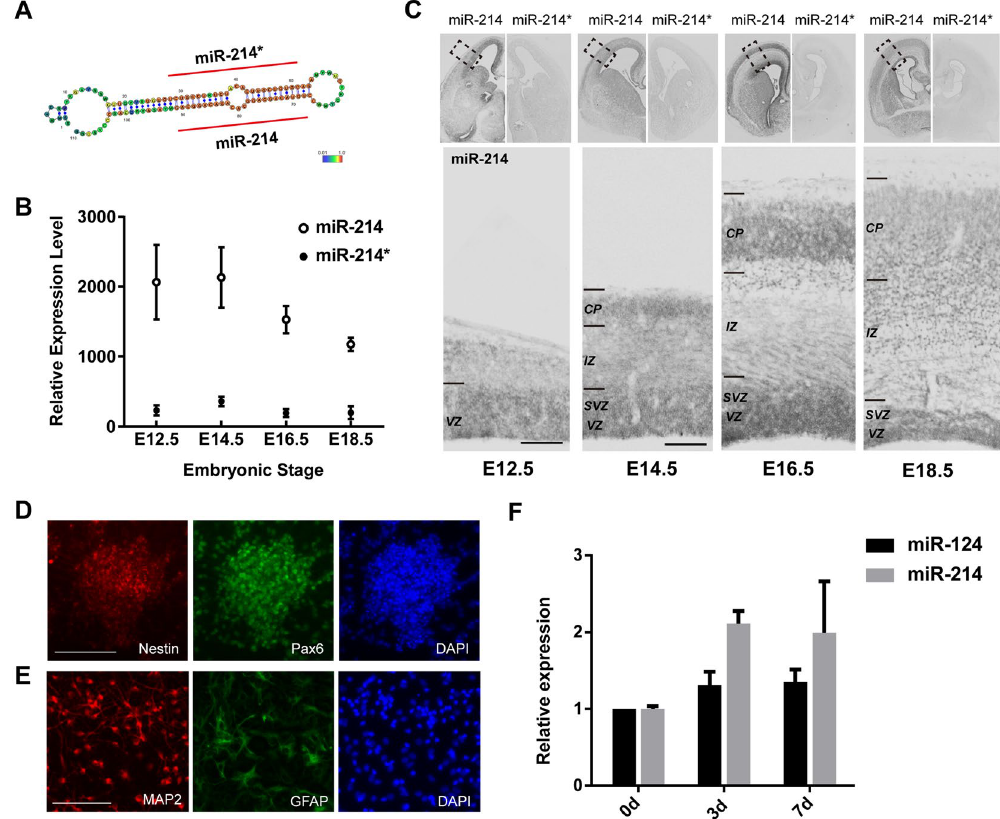
Figure 1. Expression pattern of miR-214 in the developing neocortex and cultured neural stem cells. ( A ) Predicted secondary structure and sequence conservation of the miR-214 precursor hairpin. The maturation regions of miR-214 and miR-214 * are marked with red straight lines, and the colour of the base represents its conservation with higher conservation in red and lower in blue (modified from Rfam database 11.0). ( B ) Microarray analysis of the expression level of the mature miR-214 and miR-214 * in the mouse embryonic cerebral cortex. Total RNAs of the E12.5, E14.5, E16.5 and E18.5 dorsal cortexes were extracted and tested by the LC Sciences company. Error bars show the standard error of mean. ( C ) The expression dynamics of miR- 214 and miR-214 * in the mouse embryonic cerebral cortex. In situ hybridization for miR-214 and miR-214 * on coronal sections of the embryonic telencephalon. The top left panel of each stage shows the expression of miR-214, and the top right panel shows that of miR-214 * . The bottom panel shows the corresponding neocortical areas of the black dashed boxes of the top left panel at a higher magnification. VZ, ventricular zone; SVZ, sub-ventricular zone; IZ, intermediate zone; CP, cortical plate; the scale bar in C is 100 μ m. ( D , E ) Immunofluorescence of NSCs during proliferation conditions ( D ) and the differentiation stage ( E ). ( D ) Staining of the neural sphere with neural stem cell markers Pax6 (green) and Nestin (red) ( E ) Immunofluorescence of differentiated cells 3 days after induction with neuron marker MAP2 (Red) and astrocyte marker GFAP (green). Scale bar: 100 μ m. (F) Expression levels of miR-214 and miR-124 before and after differentiation of NSCs. Total RNA of the NSCs and differentiated cells was extracted and tested by real-time PCR, and the miR-214 signal was normalized to that of the U6 snRNA (n = 3, p =